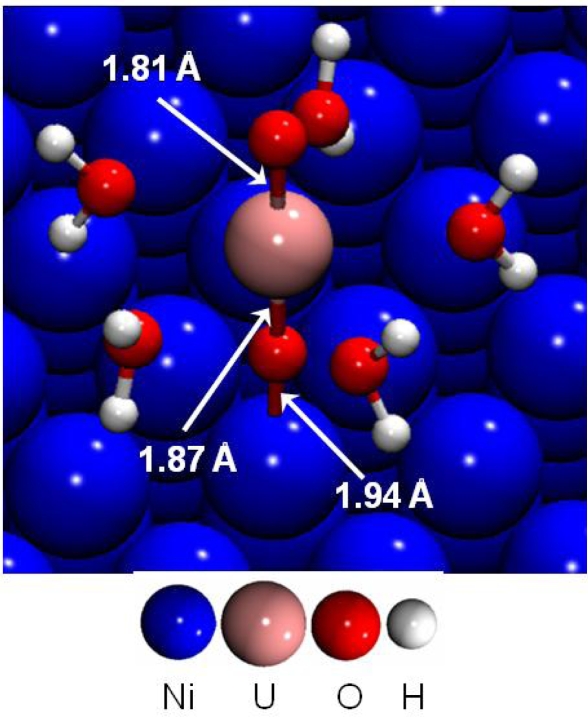
Adsorption of UO2(H2O)52+ on the dry Ni(111) at low coverage.